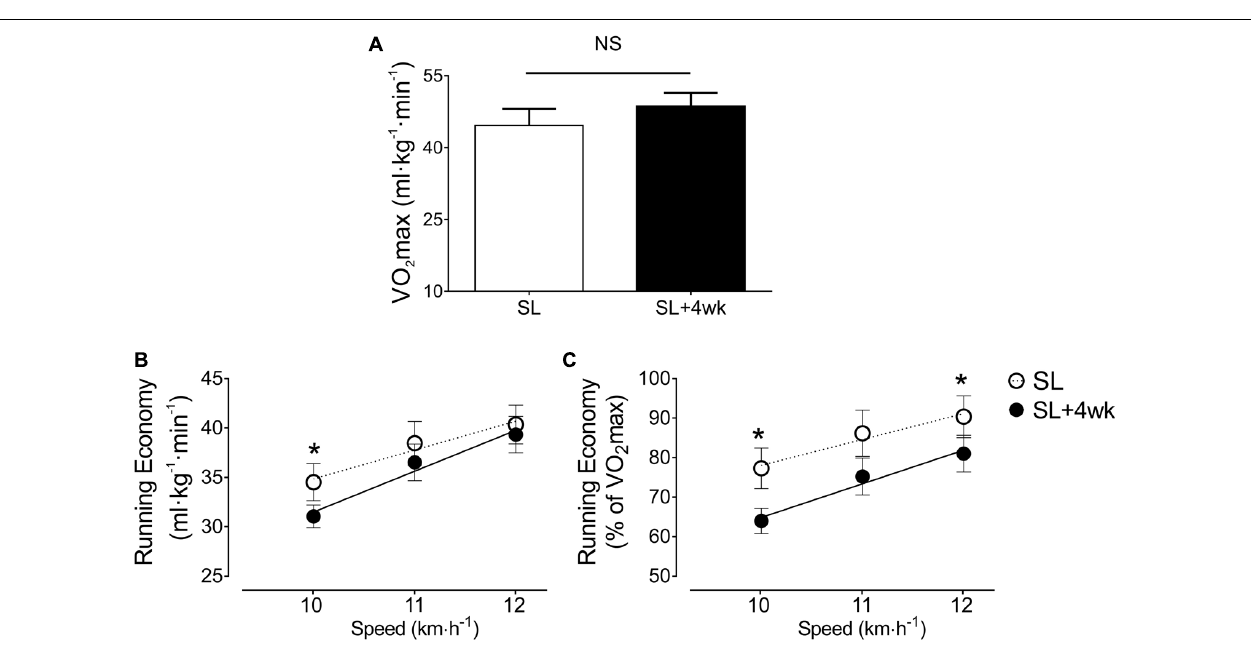
FIGURE 3 | Four weeks of plyometric training improve running economy (RE). (A) Sea level maximal oxygen uptake (VO 2 max) (ml · kg − 1 · min − 1 ) before (SL, white column) and after (SL +4 week, black column) 4 weeks of plyometric training. (B) Sea level running economy (ml · kg − 1 · min − 1 ) before (SL, white dots) and after 4 weeks of plyometric training (SL +4 week, black dots). Note that at 10 km · h − 1 the plyometric training group showed a decrease of VO 2 compared to SL pre-training. (C) RE normalized to VO 2 max which showed that at 10 km · h − 1 and 12 km · h − 1 plyometric training group displayed an improvement of RE. ANOVA with 2 factors, followed by Holm-Sidak post hoc ; ∗ p < 0.05. NS, denotes no significant differences between time